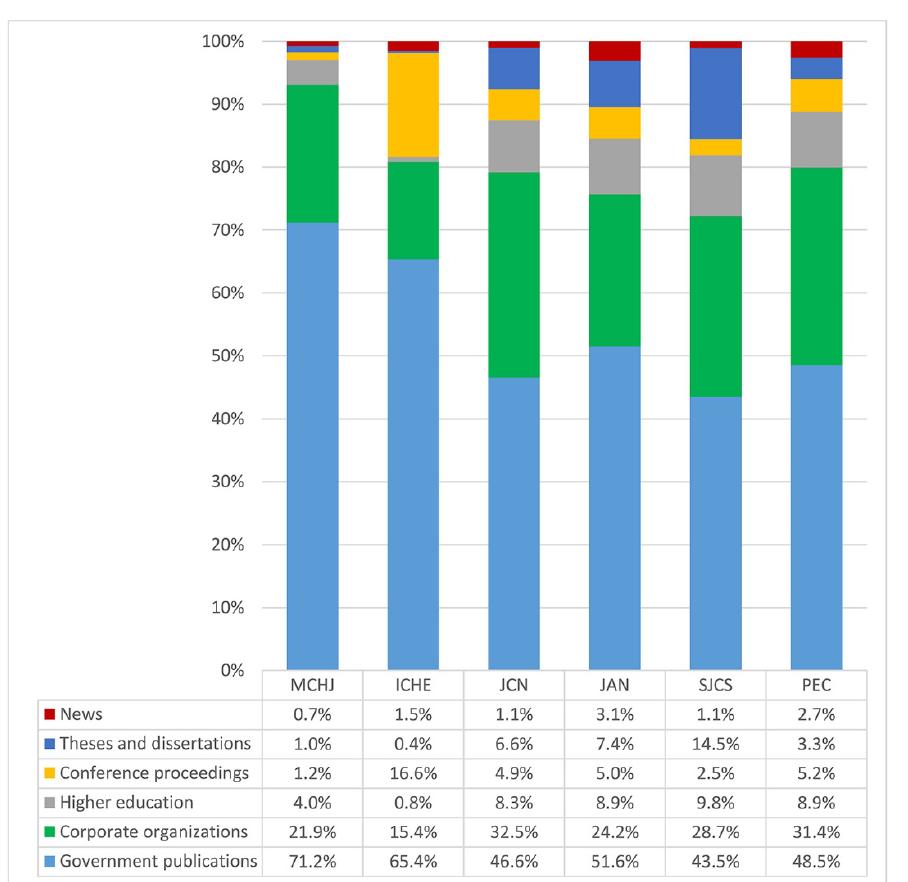
Figure 3 Grey literature type and prevalence for each